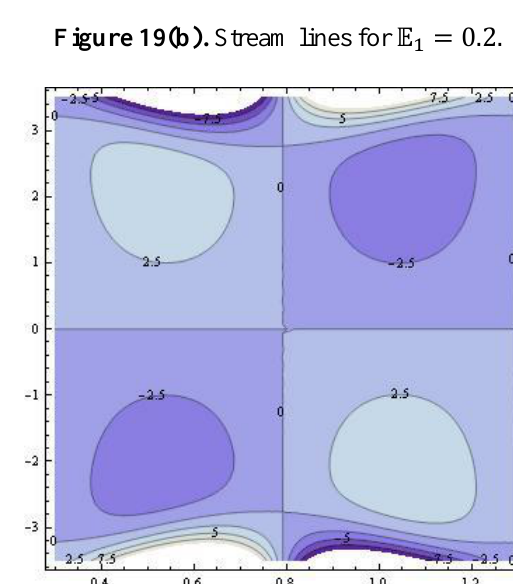
Figure 20(a). Stream lines for 𝔼